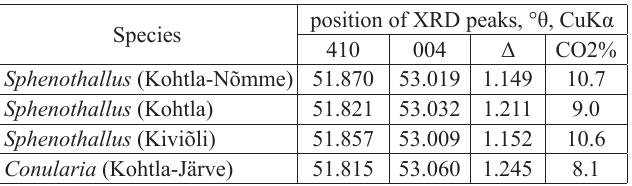
Table 1. Carbonate content of Sphenothallus and Conularia apatite according to equation y = 10.643x 2 - 52.512x + 56.986, where Y = CO wt% and x = Δ (004)-(410) (Schuffert et al. 1990).